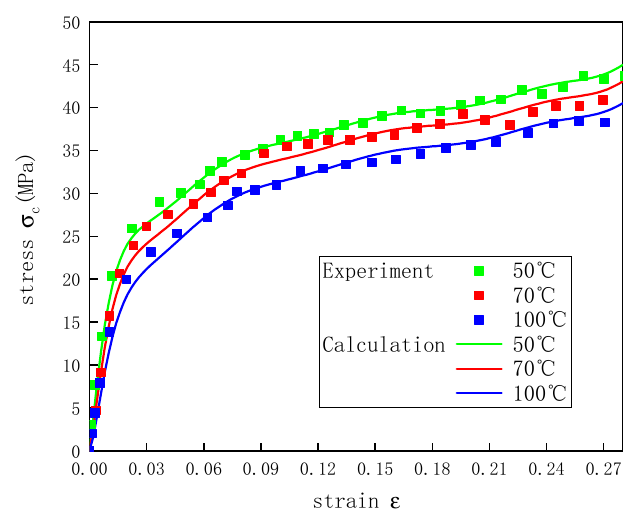
− 1 and di ff erent temperatures. Polymers 2020 , 12 , x FOR PEER REVIEW